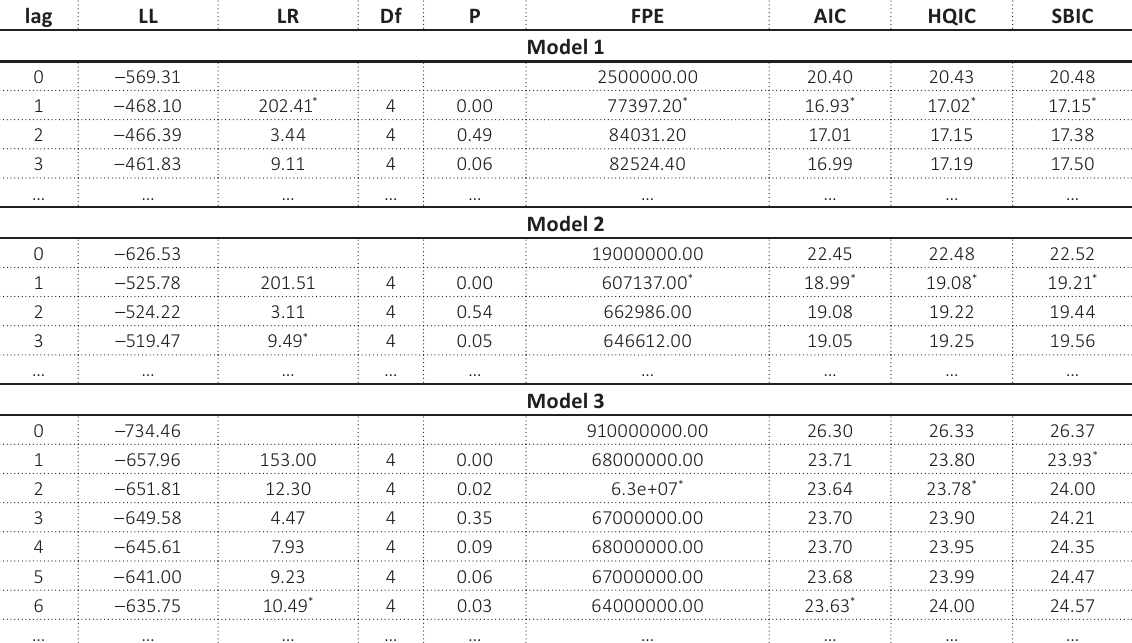
Table 9. Definition of lags for the case of